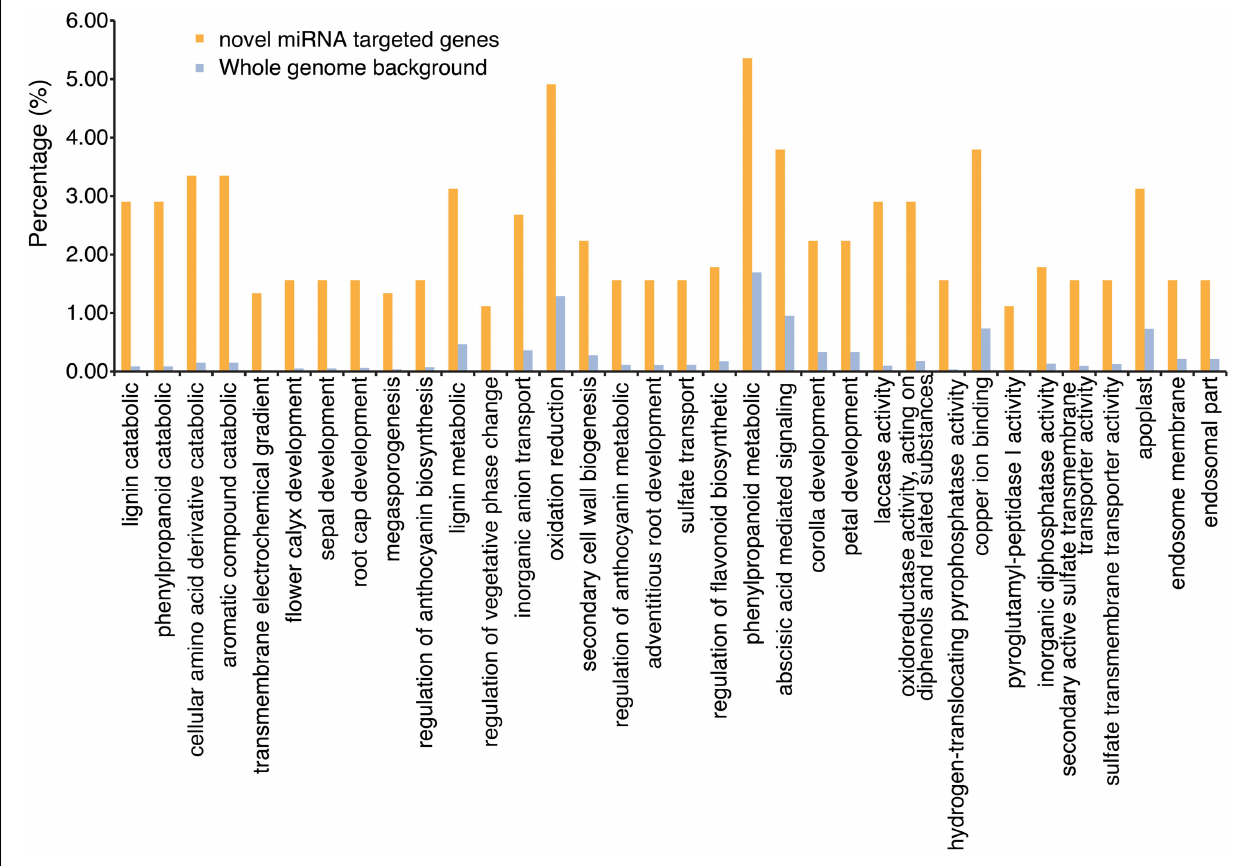
predicted target mRNAs associated with a particular term that is significantly over-represented, and the percentage of all mRNAs in the genome associated with the same term. Significantly over-represented GO terms were determined by hypergeometric test with an FDR correction (alpha =